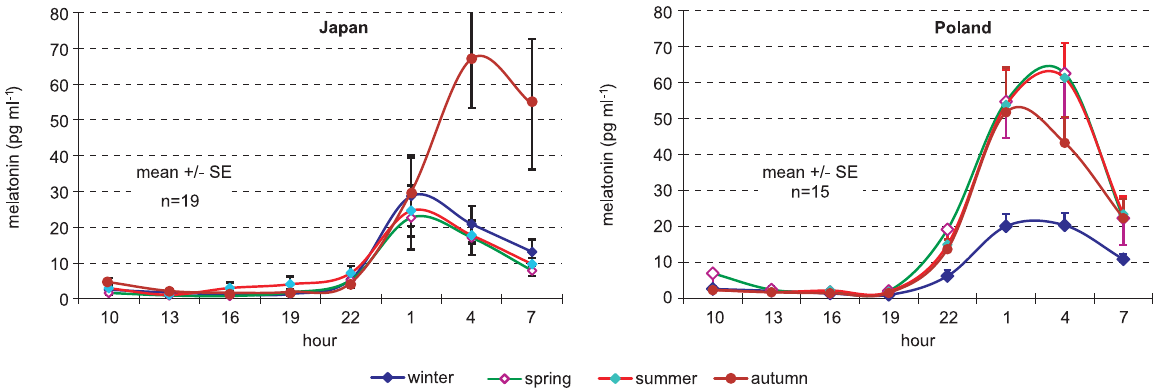
Fig. 3. Mean seasonal daily courses of melatonin concentration at Japanese and Polish